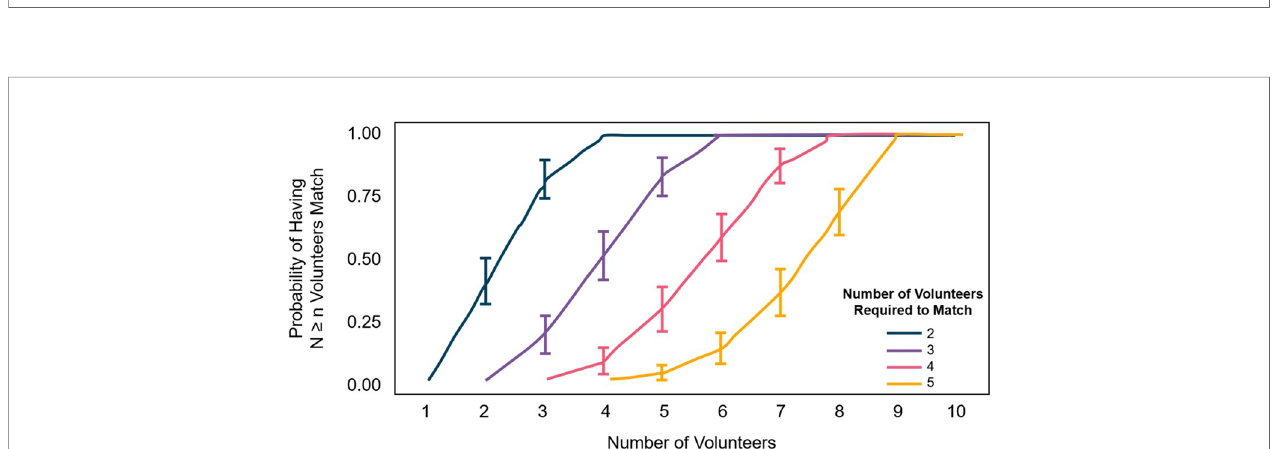
FIGURE 3 | Probability (with 95% CL) of having the number of volunteers who need to identify each photo in order for an agreement of 2 (blue), 3 (purple), 4 (red), or 5